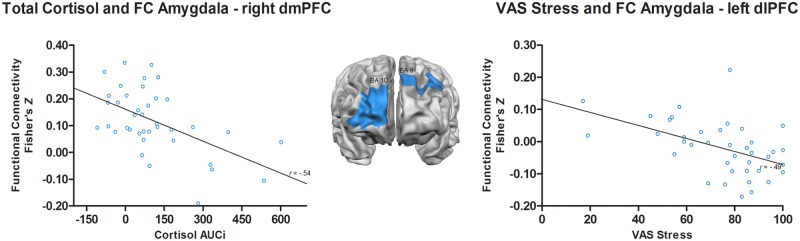
Association of amygdala rsFC with total cortisol and subjective stress.The left scatterplot illustrates the negative correlation between total cortisol and strength of the baseline amygdala—right dmPFC connectivity. The right scatterplot illustrates the negative correlation between subjective stress and strength of the reactivity amygdala—left dlPFC connectivity.